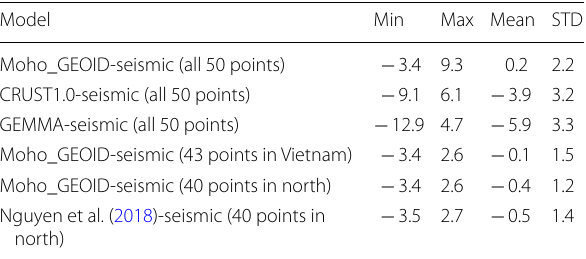
Table 5 Statistics of differences between Moho depths from the Moho_GEOID, Nguyen et al. (2018), CRUST1.0, and GEMMA global model with those of 50 seismic stations. (Unit: